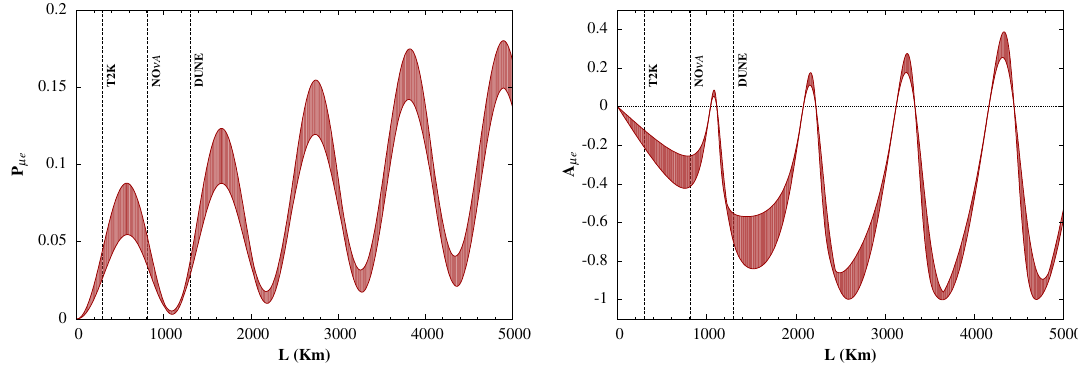
Figure 5 . Plots of the transition probability ( P (cid:22)e ) and CP asymmetry parameter ( A (cid:22)e ) with baseline length L for NO ( E = 1GeV). The bands are due to 3 (cid:27) ranges of the mixing angles and also the ranges for the parameters 79 : 6 (cid:14) < (cid:18) < 101 : 6 (cid:14) and 1 : 79 < j (cid:17) 1 =(cid:17) 2 j < 2 : 11. In this case, (cid:14) is not (cid:12)xed, but varies over a range predicted from (3.18) with the same ranges of the mixing angles, and model parameters (cid:18) and (cid:17) 1 =(cid:17) 2 . The three vertical dashed lines and the horizontal dotted line specify the same as (cid:12)gure 3.